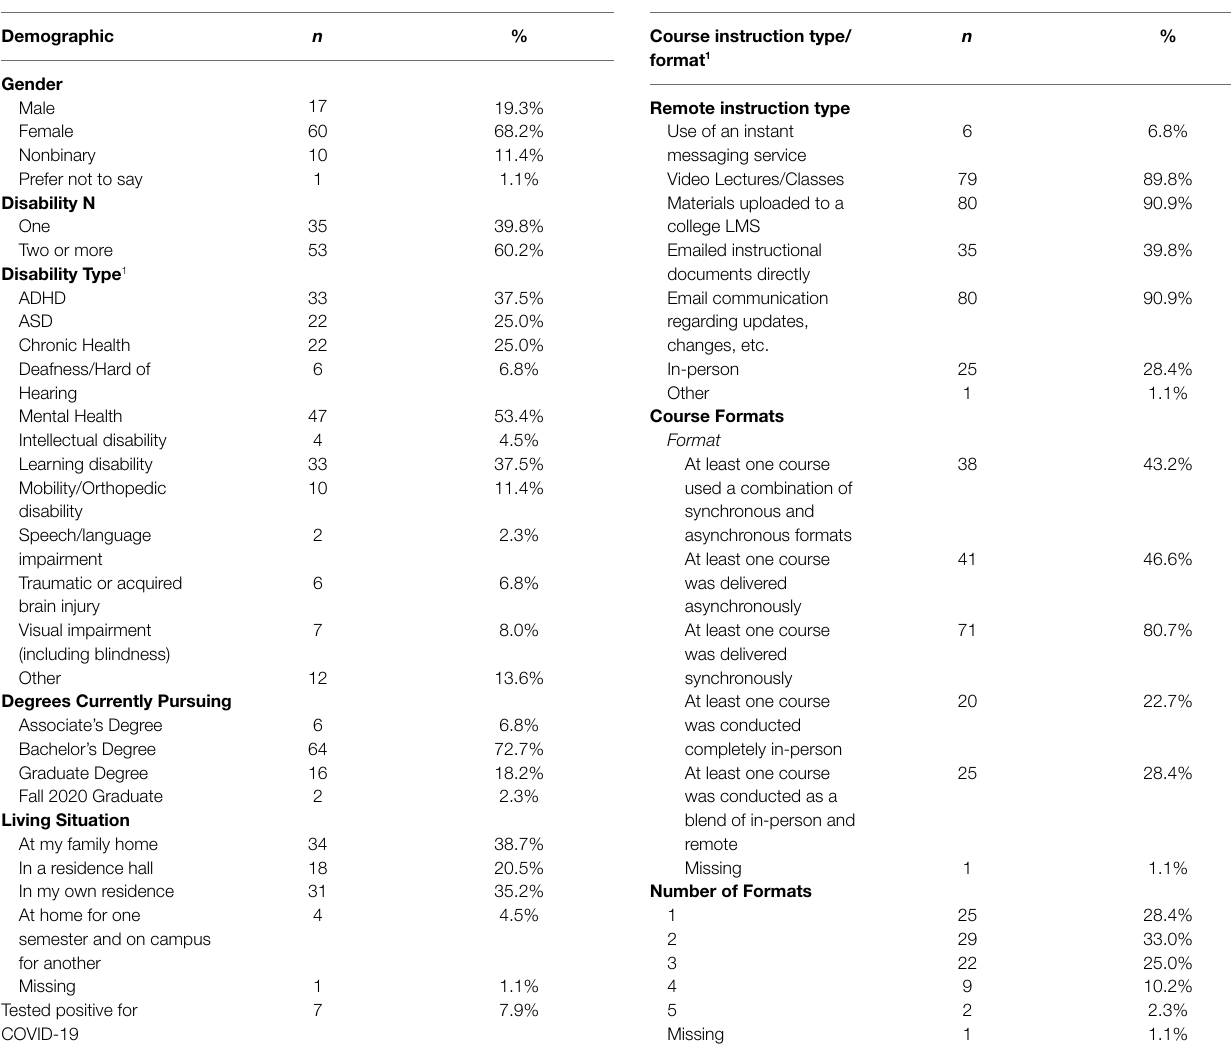
TABLE 1 | Demographic characteristics of the sample. TABLE 2 | Type and format of remote instruction received by the